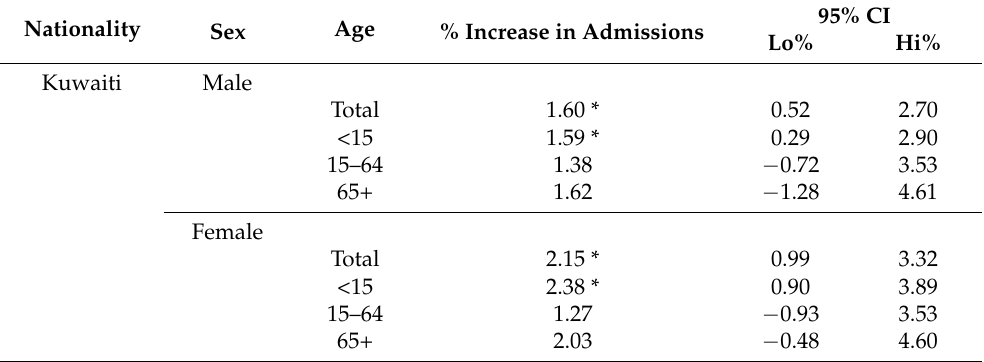
Figure 1. Associations between delayed respiratory admission and PM 2.5 exposure among different subgroups for distributed lag models up to 5 days lag. All models were adjusted for ambient temperature, relative humidity, long-term trends, and day of the week. Cum; cumulative. Table 4. In-depth subgroup analysis for the association between average PM 2.5 and respiratory admissions over 0–5 cumulative days lag period using distributed lag